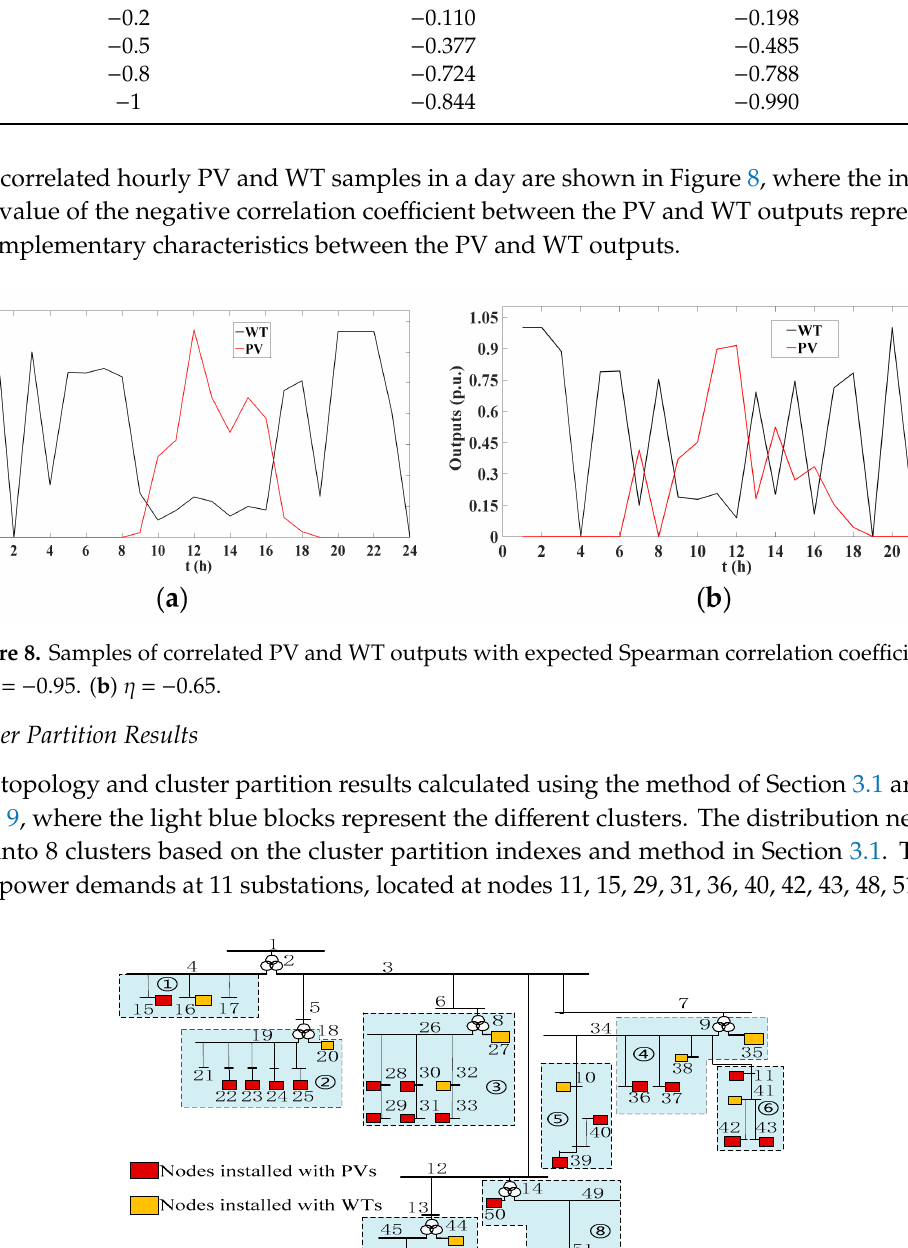
Table 2. The cluster partition indexes.